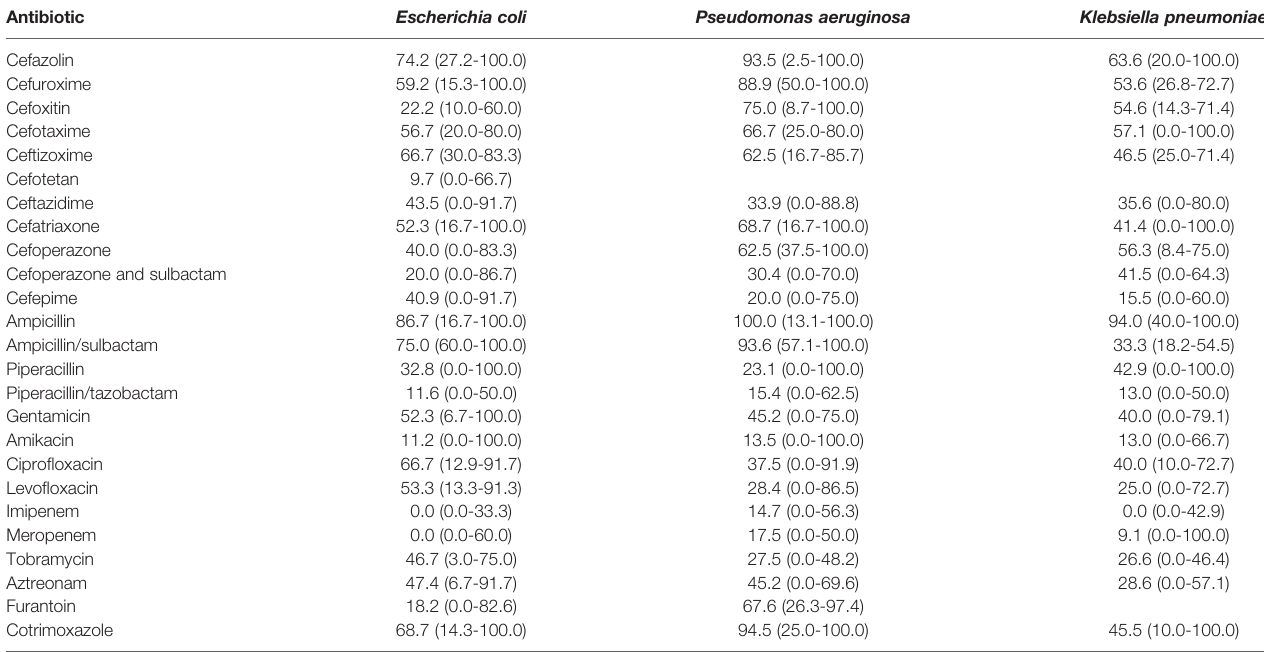
TABLE 3 | Antibiotic-resistant rate of common GN bacteria in the drug susceptibility tests (%). Antibiotic